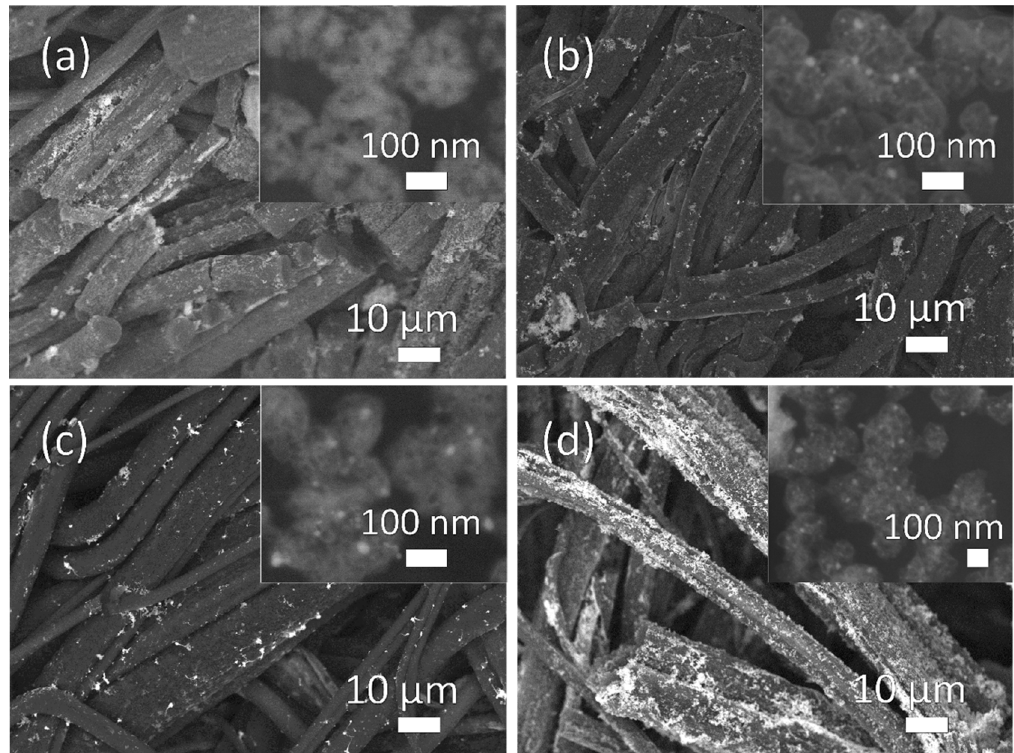
Figure 1. High-resolution scanning electron microscope (HRSEM) images of the ( a ) PMMA/ZnO, ( b ) PMMA/ZnO-Au1, ( c ) PMMA/ZnO-Au3, and ( d ) PMMA/ZnO-Au6 composite mats. Insets report the details on the surface of the different composite mats. PMMA: poly(methyl methacrylate).